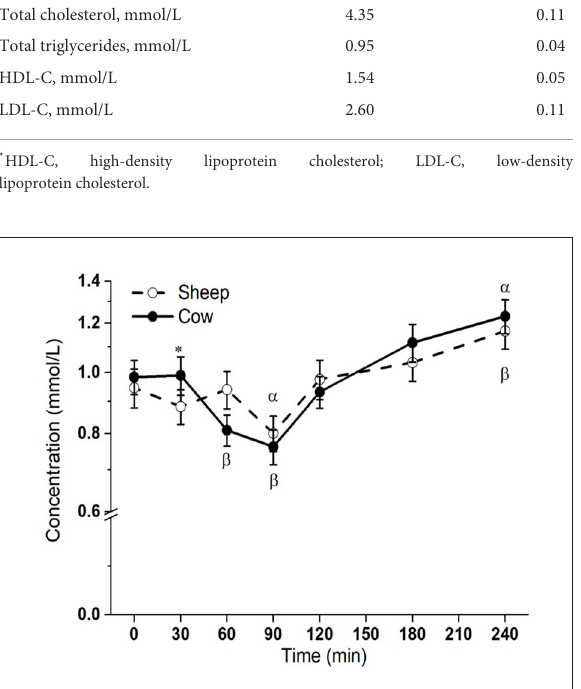
FIGURE1 Postprandial changes in plasma total triglycerides after SM and CM ingestion. Values presented as means ± SEM; * p < 0.05, ** p < 0.01, *** p < 0.001 denoted statistical significance (interaction time × milk) between sheep () and cow () milk; α and β denote significant changes ( p < 0.05) from baseline after sheep and cow milk ingestion, respectively (Sidak corrected post hocs). SM, sheep milk; CM, cow